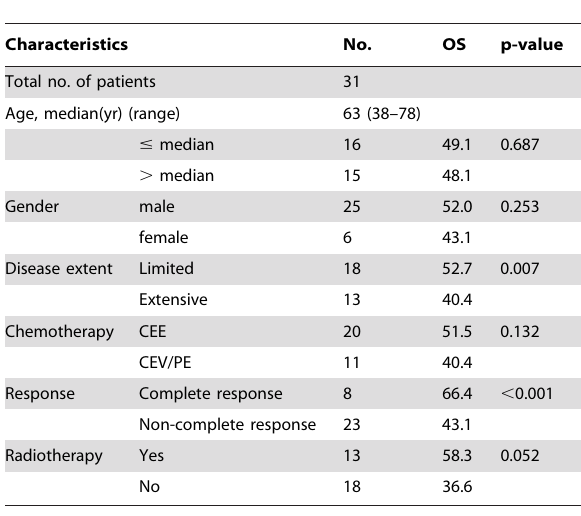
Table 1. Patient characteristics and survival.